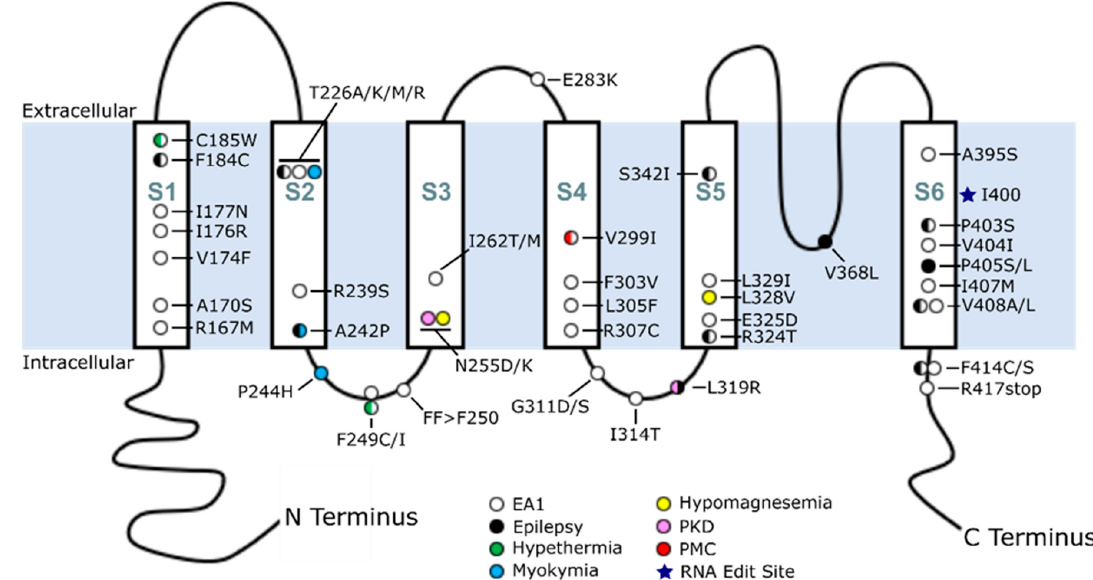
Figure 1. Map of KCNA1 mutations associated with human disease. Human mutations in KCNA1 were mapped across the protein and color-coded to indicate their clinically documented disease association. Circles with two colors represent mutations with multiple phenotypes. Multiple circles at a given amino acid position represent multiple diseases caused by different amino acid changes at the same position (e.g., N255D/K). Abbreviations: PMC, paradoxical myotonic congenita; PKD, paroxysmal kinesigenic dyskinesia.